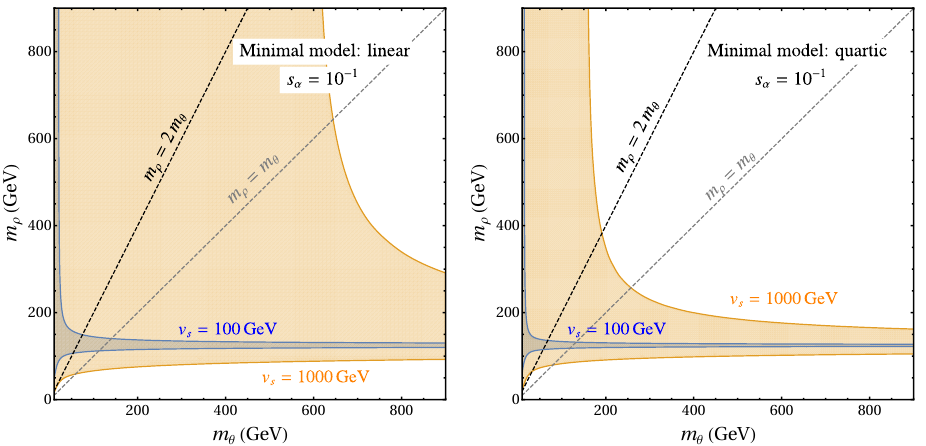
Figure 3. The colored region is the parameter space allowed by the XENON1T null-results for the linear (left) and quartic (right) models. Blue (Orange) colored region corresponds to v 100 (1000) GeV . Black and gray dashed lines represent the resonance condition with the ρ ( m 2 m ) and the degenerate case ( m θ